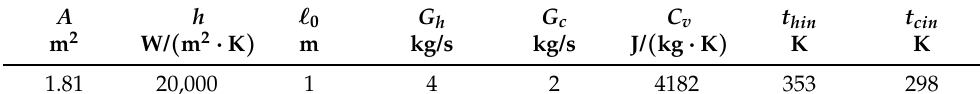
Table 1. Parameters of the demonstrated CFHX and its streams.